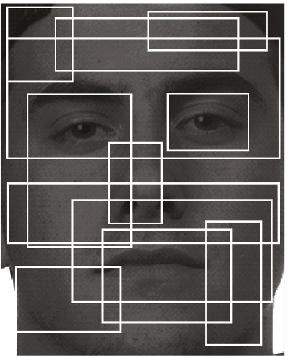
Figure 8: Some example subareas over the face image.